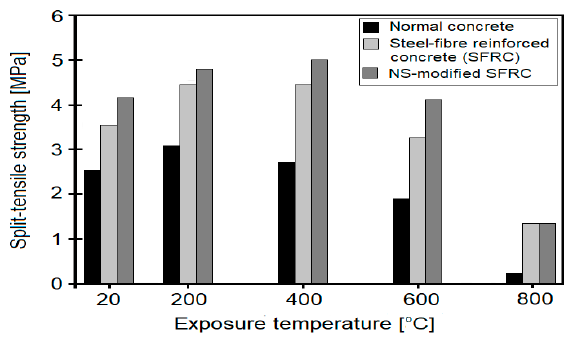
Figure 3. Split-tensile strength of normal concrete, steel-fiber reinforced concrete (SFRC) and SFRC modified with NS, as a function of temperature. Redrawn from [51].